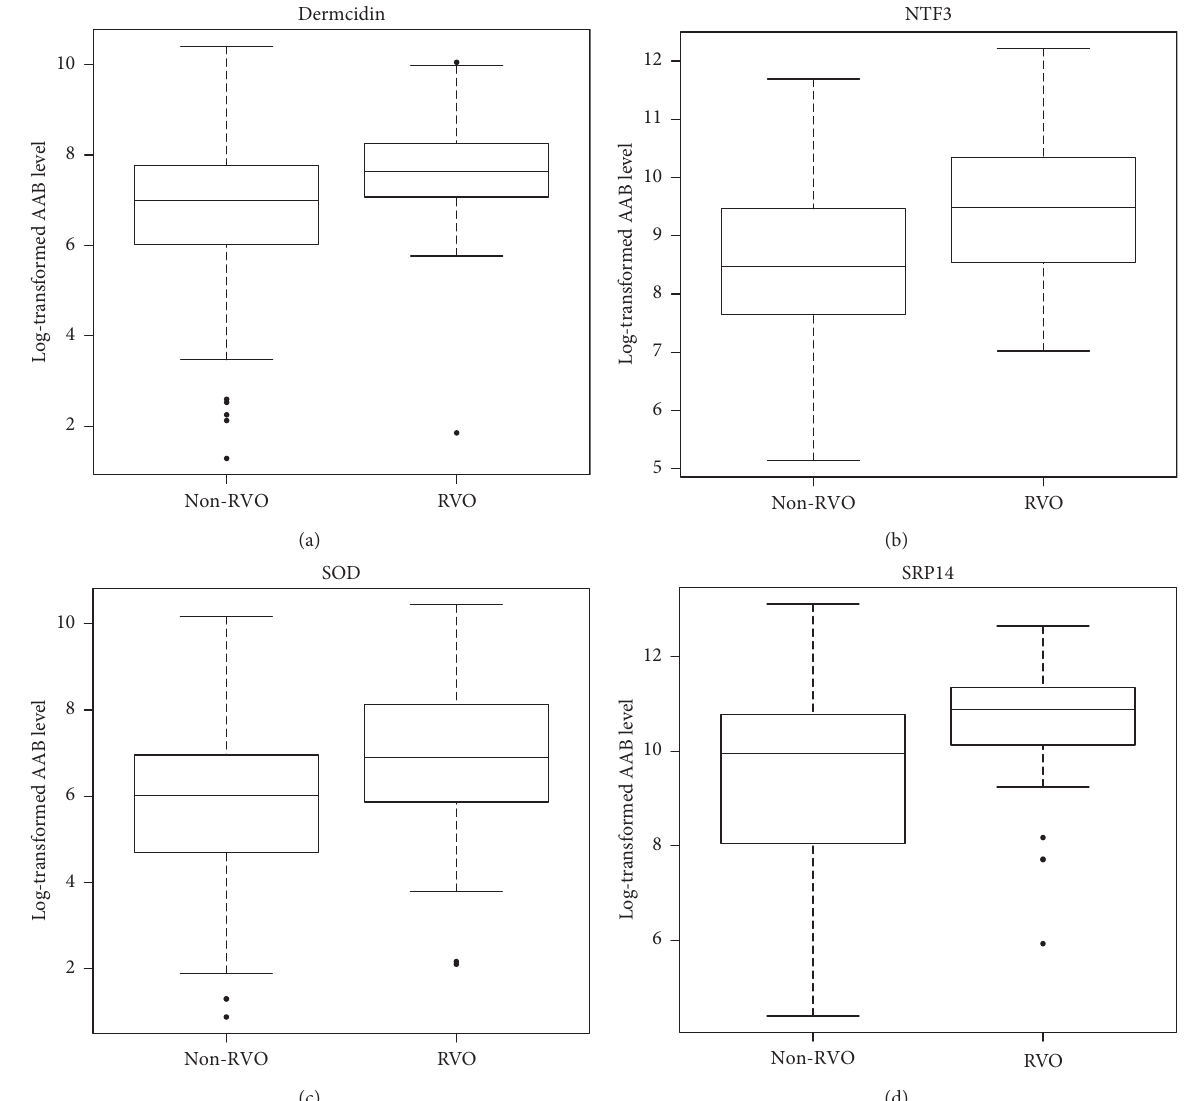
Figure 1: Distribution of significantly altered autoantibody levels in the analysis sample of the German population-based Gutenberg Health Study (2007–2012) stratified on retinal vein occlusion status. The boxplots of the 4 AABs that show significantly different levels in the RVO population in comparison with the control population are presented ( p value < 0.001). Log-transformed normalized fluorescence intensity of these autoantibodies targeted against (a) dermcidin, (b) neurotrophin-3, (c) superoxide dismutase 1, and (d) signal recognition particle 14kDa protein is Table 3: Association of autoantibody levels with retinal vein occlusion in the German population-based Gutenberg Health Study (GHS), 2007–2012. Autoantibody Model 1 Model 2 Model 3 Log10-transformed autoantibody level (RVO: yes vs. no) OR Dermcidin